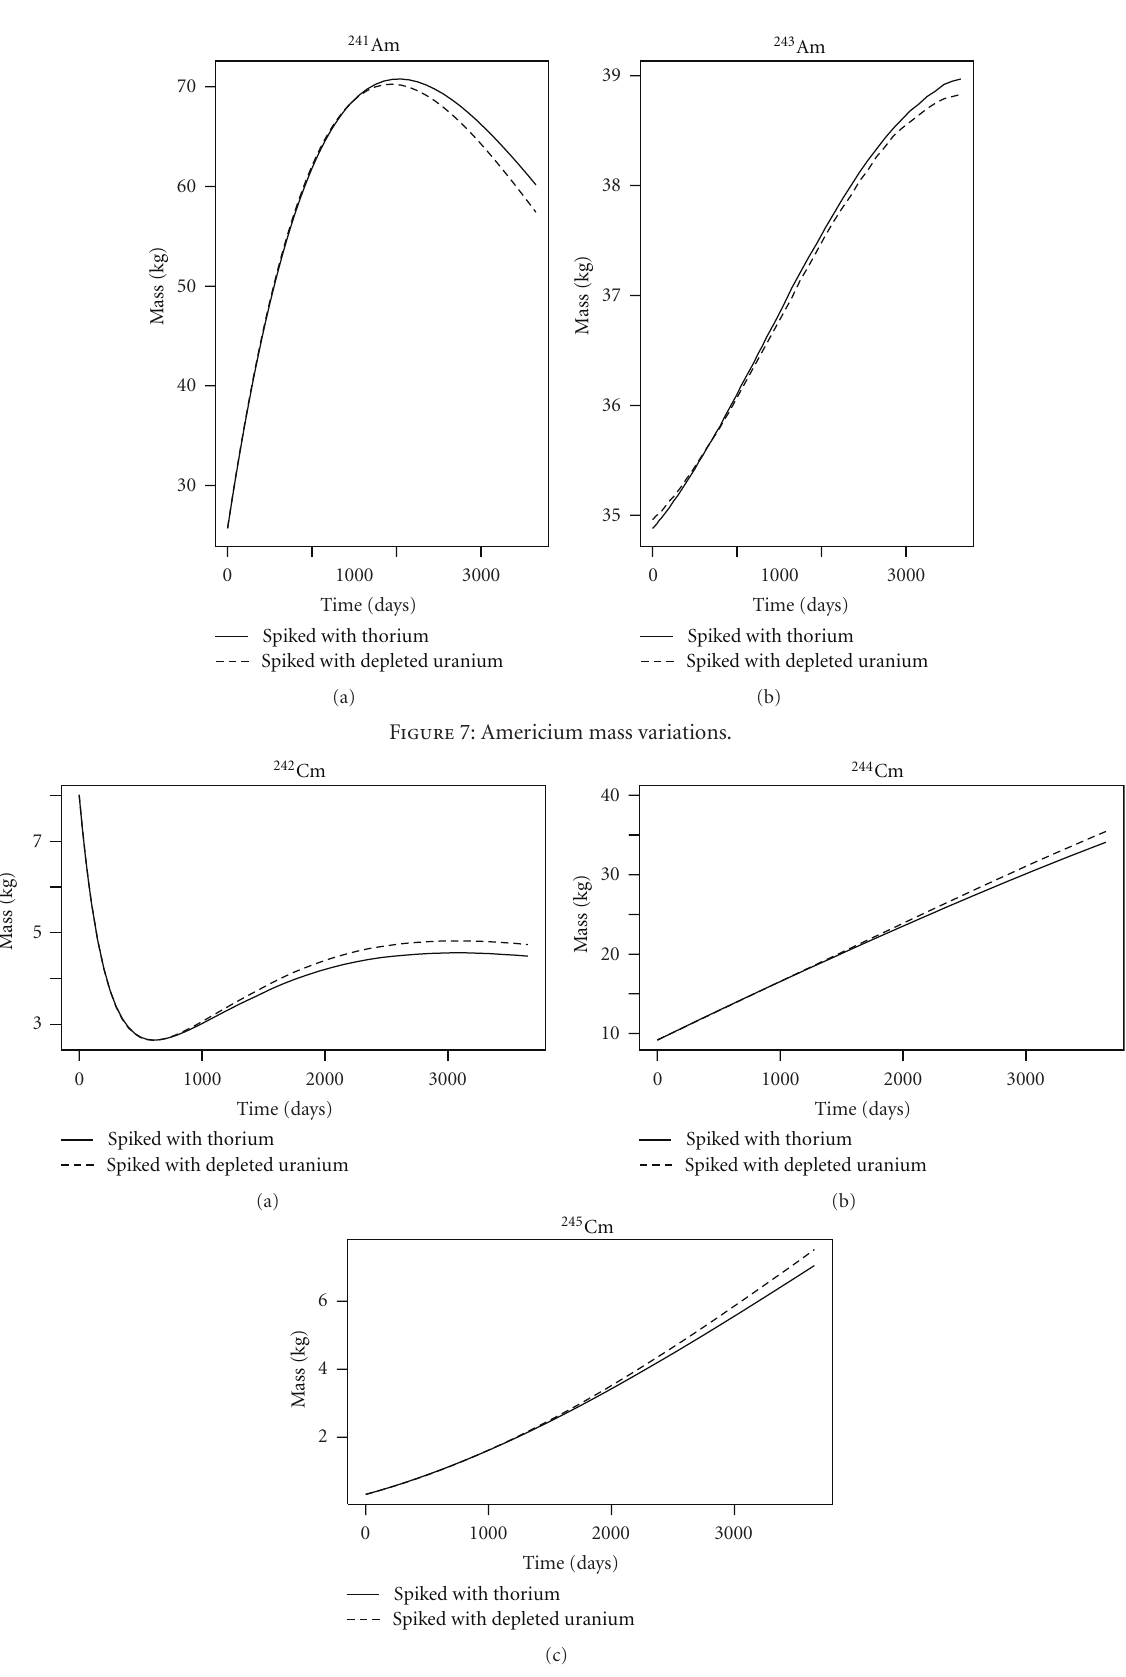
Figure 8: Curium mass